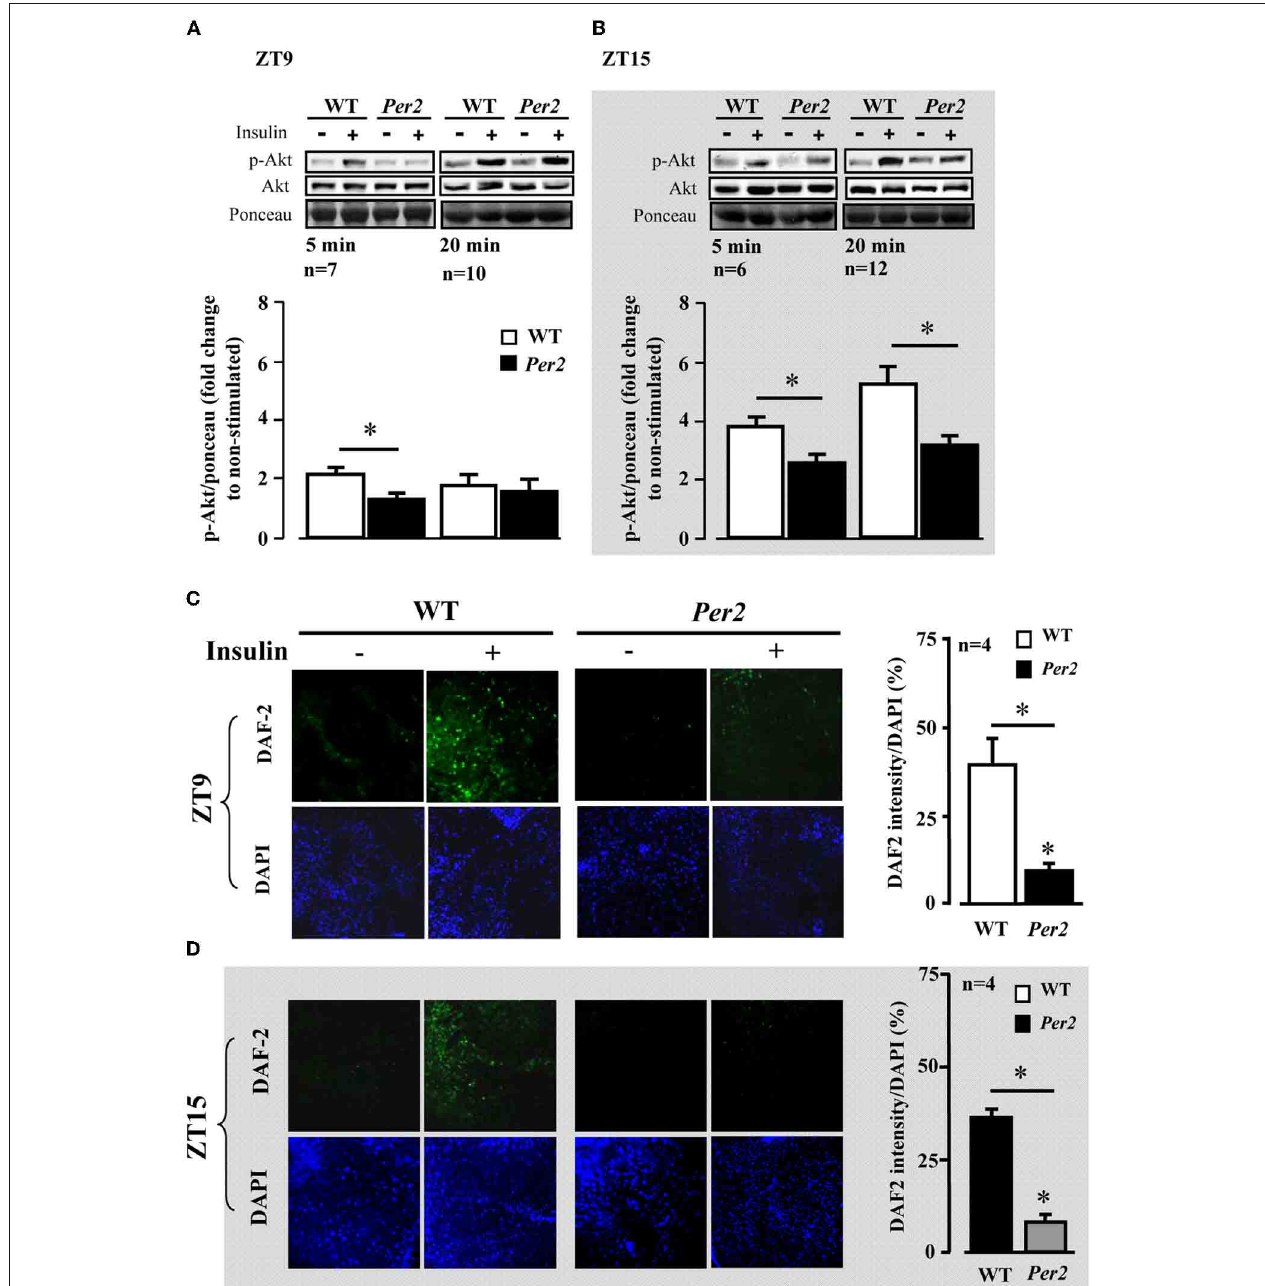
FIGURE 3 | Impaired aortic Akt activation and NO release in response to insulin in mPer2 Brdm1 mice. ( A and B ) Representative immunoblotting and respective quantifications of Akt-S473 phosphorylation stimulated by insulin (100nmol/L, 5 or 20min as indicated) at ZT9 and ZT15, respectively, in aortas of WT and mPer2 Brdm1 mice. ( C and D ) Confocal microscopic analysis of insulin-stimulated NO production in aortic endothelial layer measured by